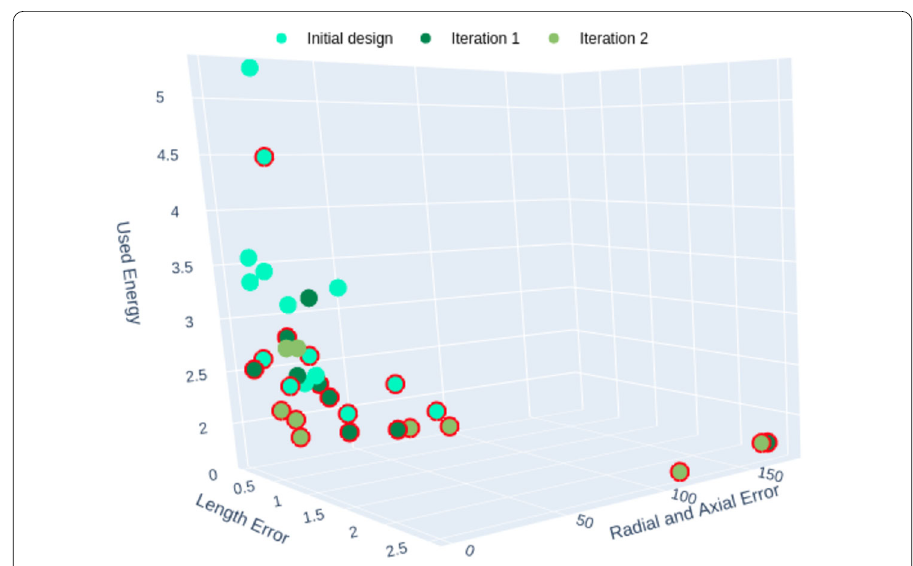
Figure 11 Case Study 1: PMs values of initial experimental design (cyan), iteration k = 1 (dark green) and iteration k = 2 (olive green). The red circle around the dots mark the runs belonging to the final Pareto